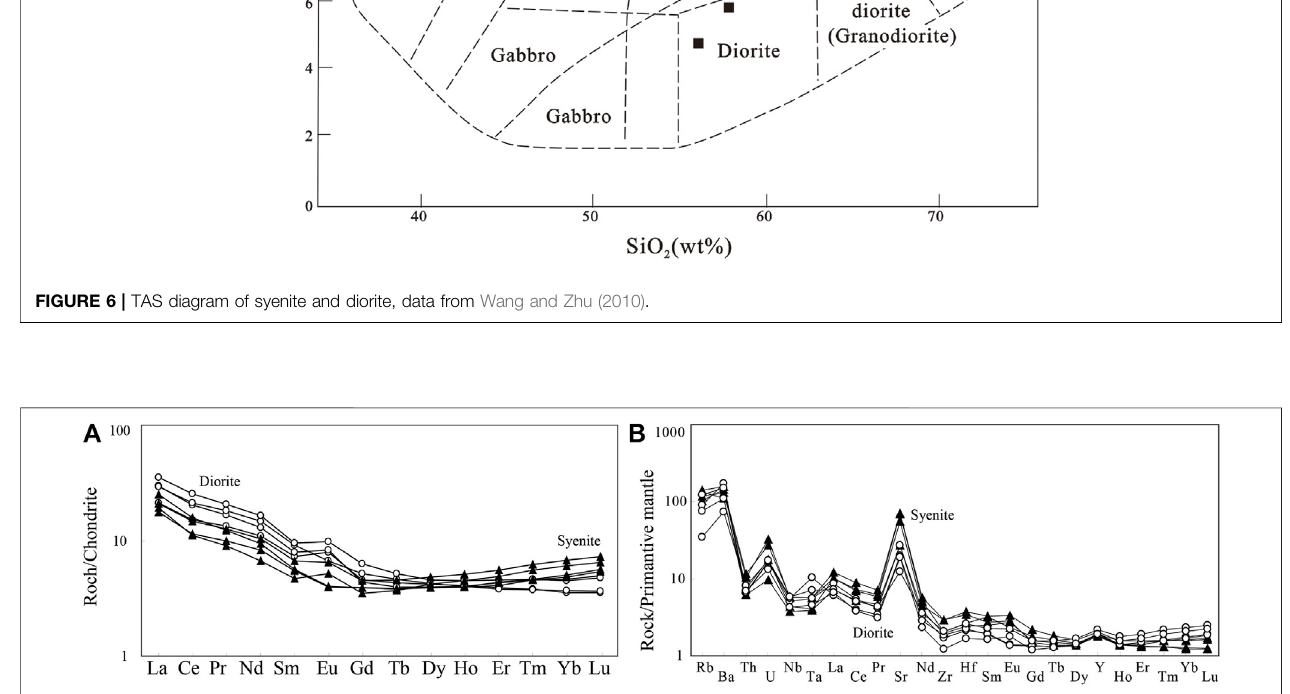
Frontiers in Earth Science |